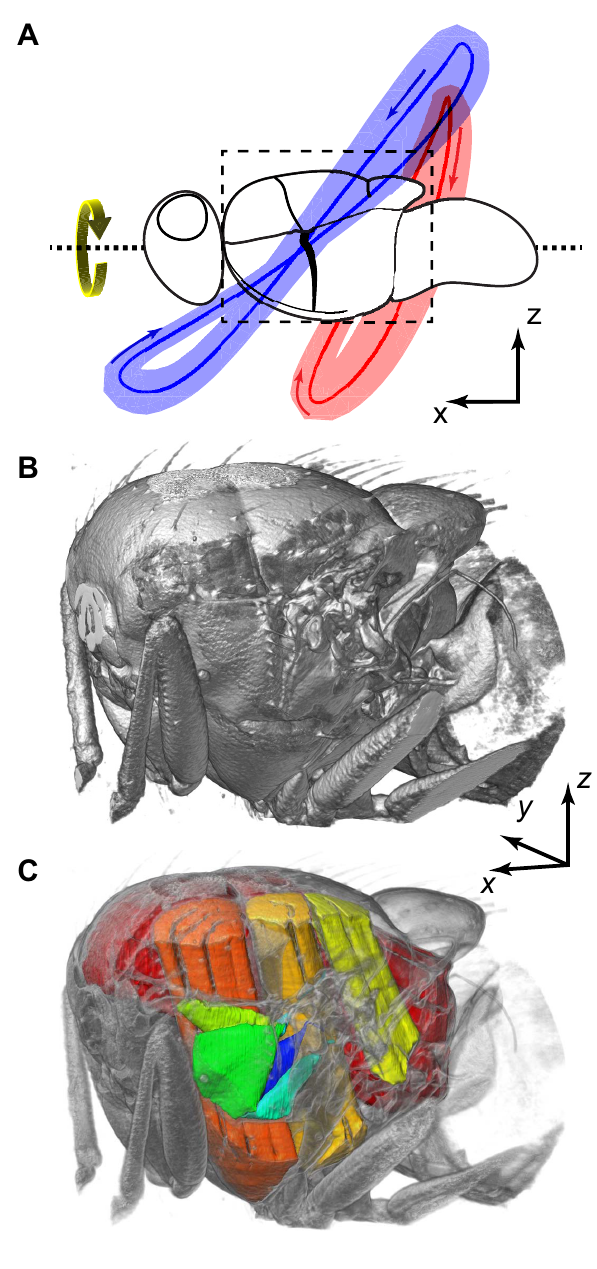
Figure 2. Overview. (A) Mean (red/blue lines) and standard deviation (red/blue shading) of wing tip position through all of the wingbeats of all four flies, showing differences in wing tip path between the left, high-amplitude (blue) and right, low-amplitude (red) wings. The arrows indicate the direction of the wings’ movement. (B) External visualization of the thorax, covering the region outlined in (A). (C) Cutaway visualization of the thorax showing the five steering muscles analysed (green to blue) and the power muscles (yellow to red). Movie S1 provides an animated overview of the movements of these muscles (view Movie S1 here).